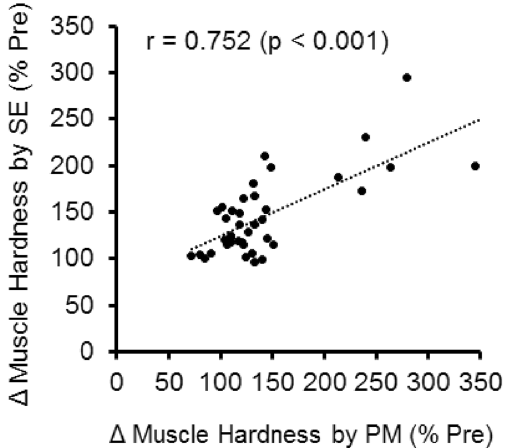
Figure 7. Relationship between normalized muscle hardness assessed by push-in meter (PM) and that by strain elastography (SE). A significant correlation was evident (r = 0.752, p < 0.001, regression equation: y = 0.5x + 74.0).